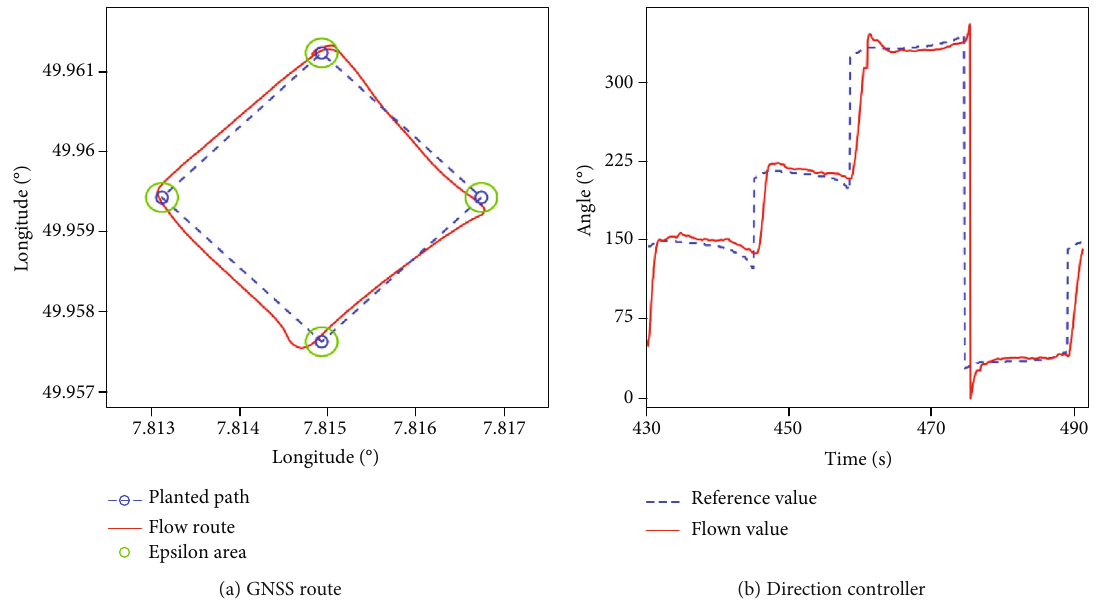
Figure 11: The desired route and the navigation points (red) the airframe has to reach (a). If the airframe attains the epsilon area (green), the navigation unit commands to fl y to the next destination. The fl own route is shown in black. In (b), the commanded course (blue) and the fl own curse (red) are contrasted. The planned altitude (blue) and the actual altitude (red) are